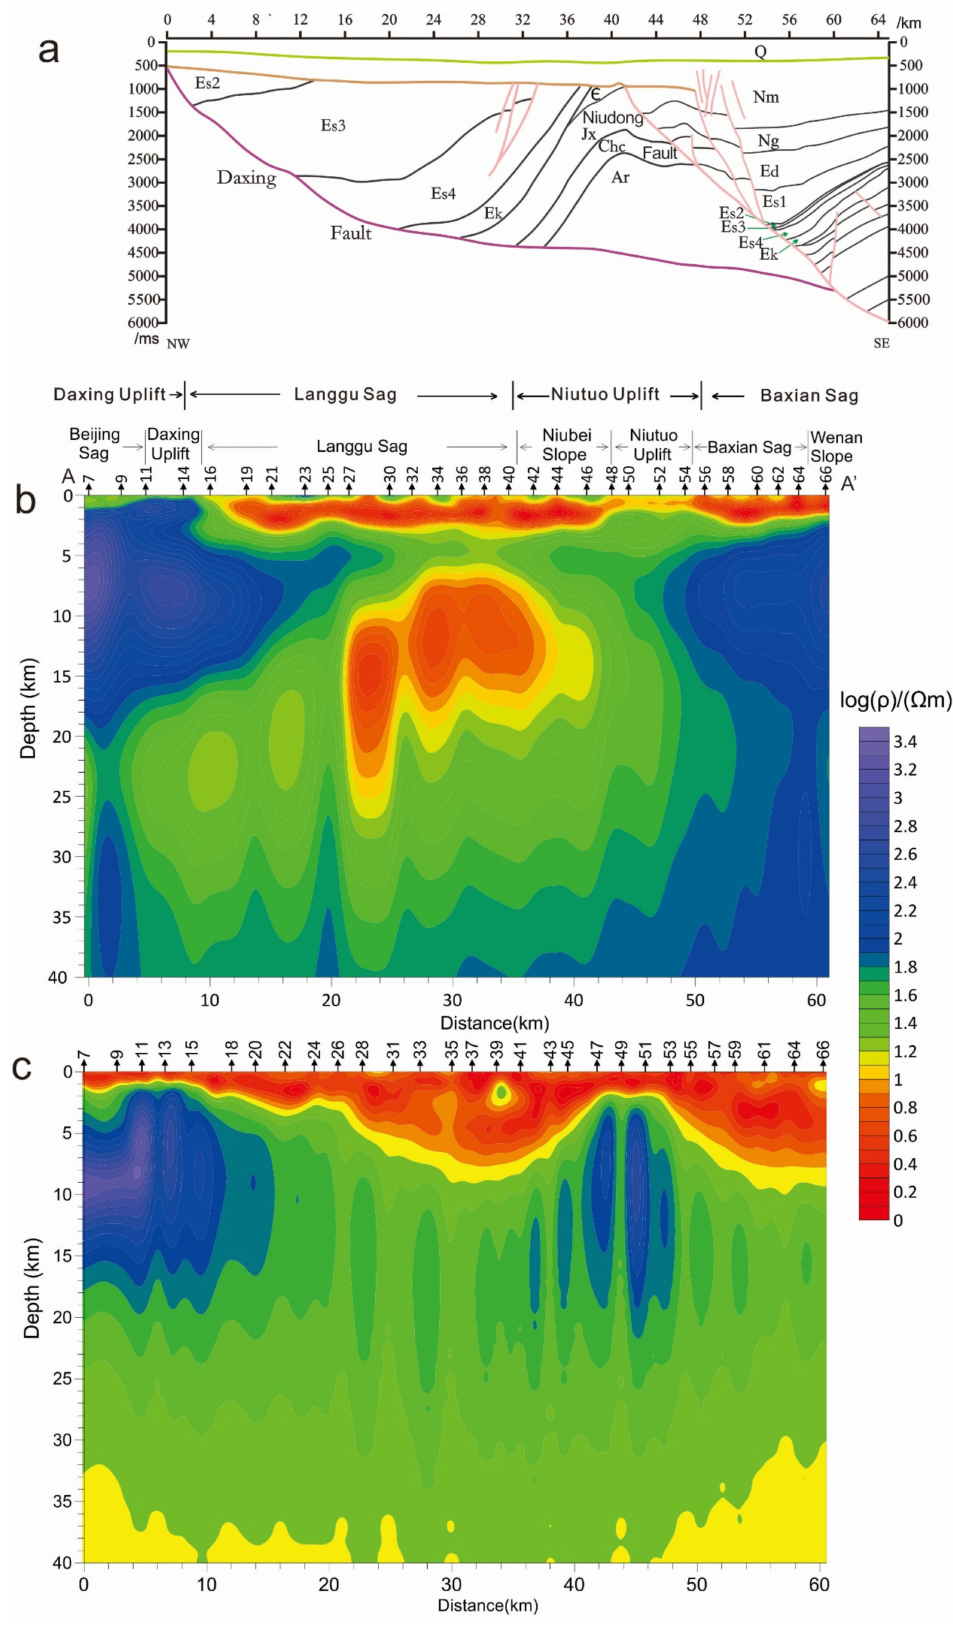
Figure 8. Comparison diagram of the inversion results for profile AA’. ( a ) Seismic profile near AA’. ( b ) The 2D inversion result of the MRR (7 and 8). ( c ) The 2D inversion result of the